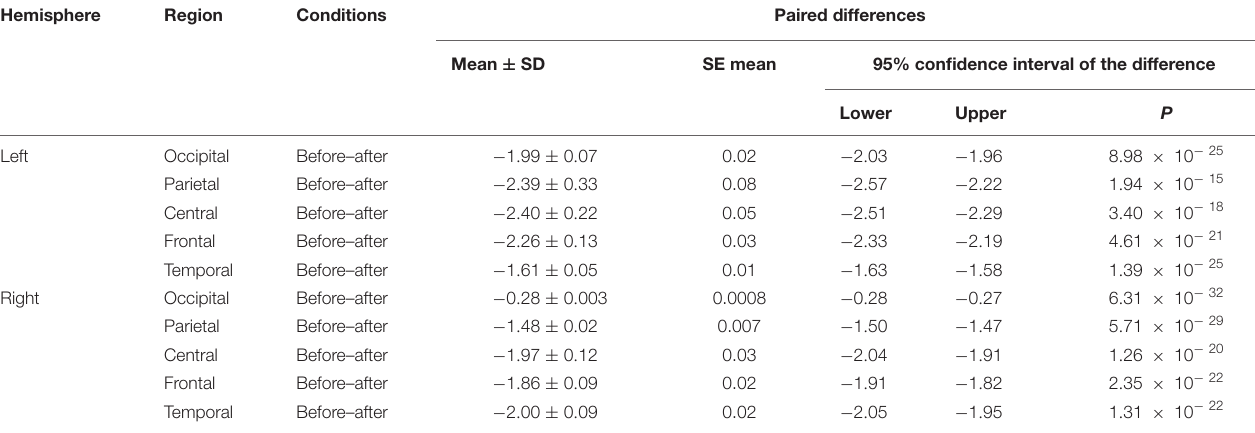
TABLE 7 | The results of paired t -test for average theta power before and after each regional condition for healthy subjects. Hemisphere Region Conditions Paired differences Mean ± SD SE mean 95% confidence interval of the difference Lower Upper P Left Occipital Before–after − 2 . 58 ± 0 . 47 0.11 Parietal Before–after Central Before–after Temporal Before–after Right Occipital Before–after Before–after Central Before–after Frontal Before–after − 2 . 34 ± 0 . 38 Temporal Before–after − 3 . 15 ± 0 . 41